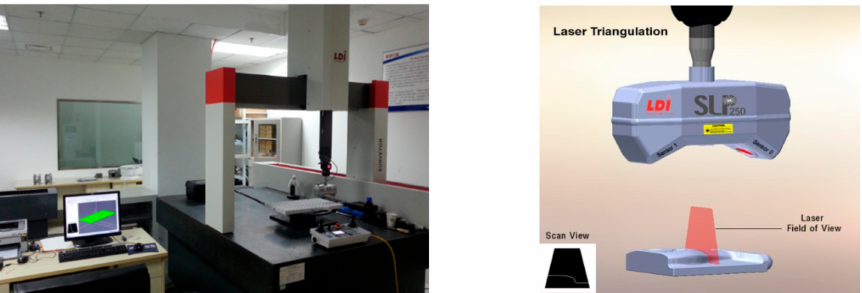
Figure 7. LDI-Surveyor ZS/SLP ultra-high accuracy high-speed 3-D laser scanning system and the structure of scanning